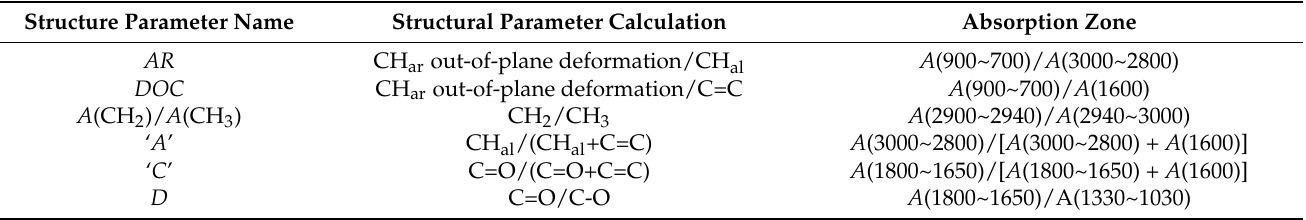
Table 2. Calculation of semi-quantitative structural parameters of anthracite FTIR. Structural Parameter